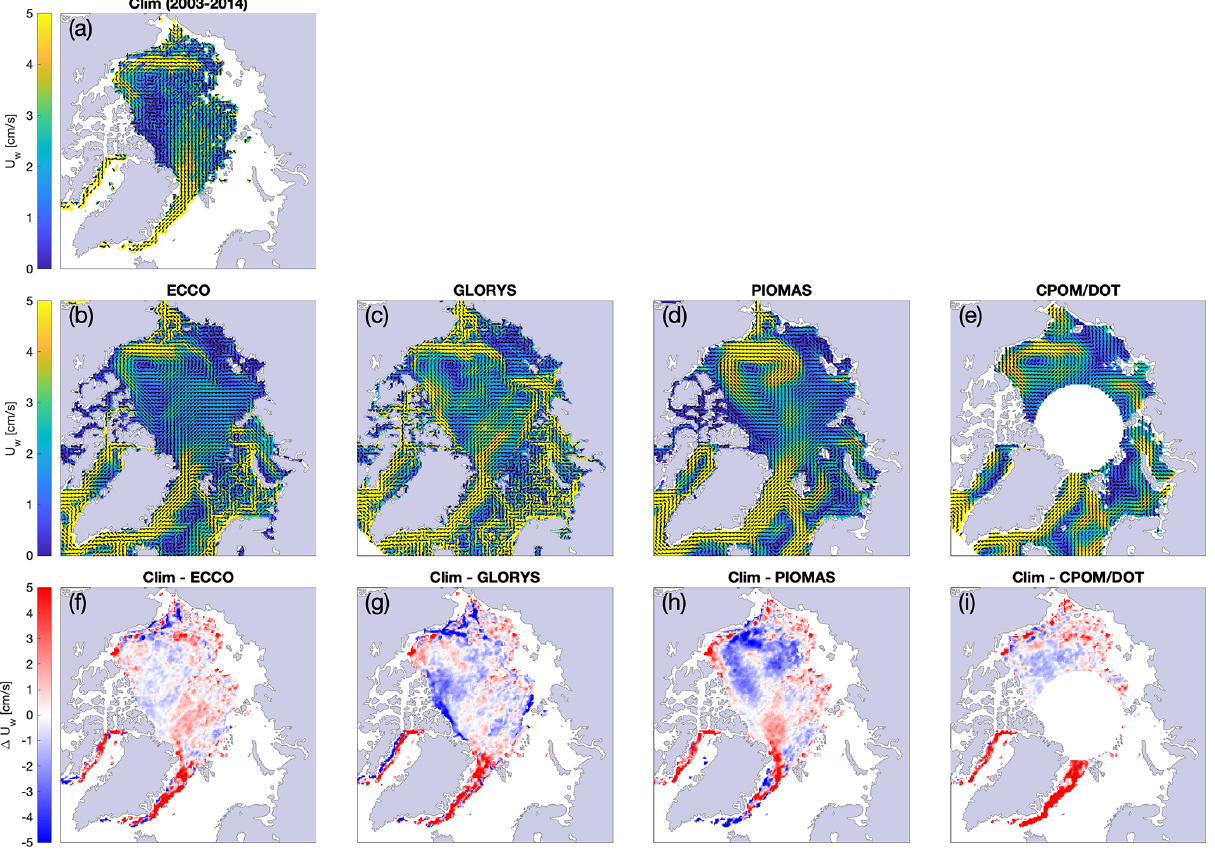
Figure 11. The 2003–2014 climatology of the ocean currents from (a) intercept in the linear free-drift parameterization between IABP buoy data and ERA5 winds; (b) ECCO, at a depth of 5m; (c) GLORYS, at a depth of 5m; (d) PIOMAS, at a depth of 7.5m; and (e) geostrophic ocean currents from the dynamic ocean topography. Panels (f) through (i) show the difference in velocity between the ocean currents in panel (a) and each of the four other ocean velocity